Question: What style of plot is this figure drawn as?
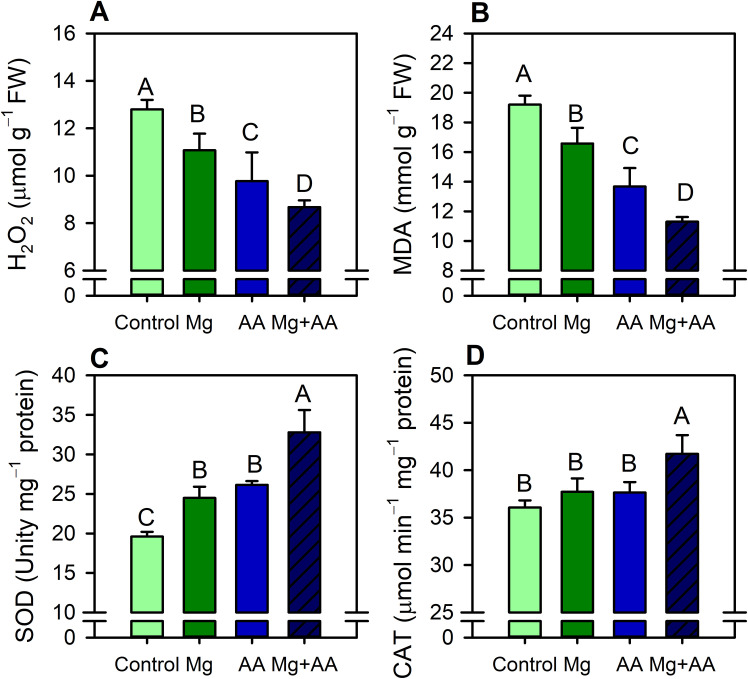
Answer: bar